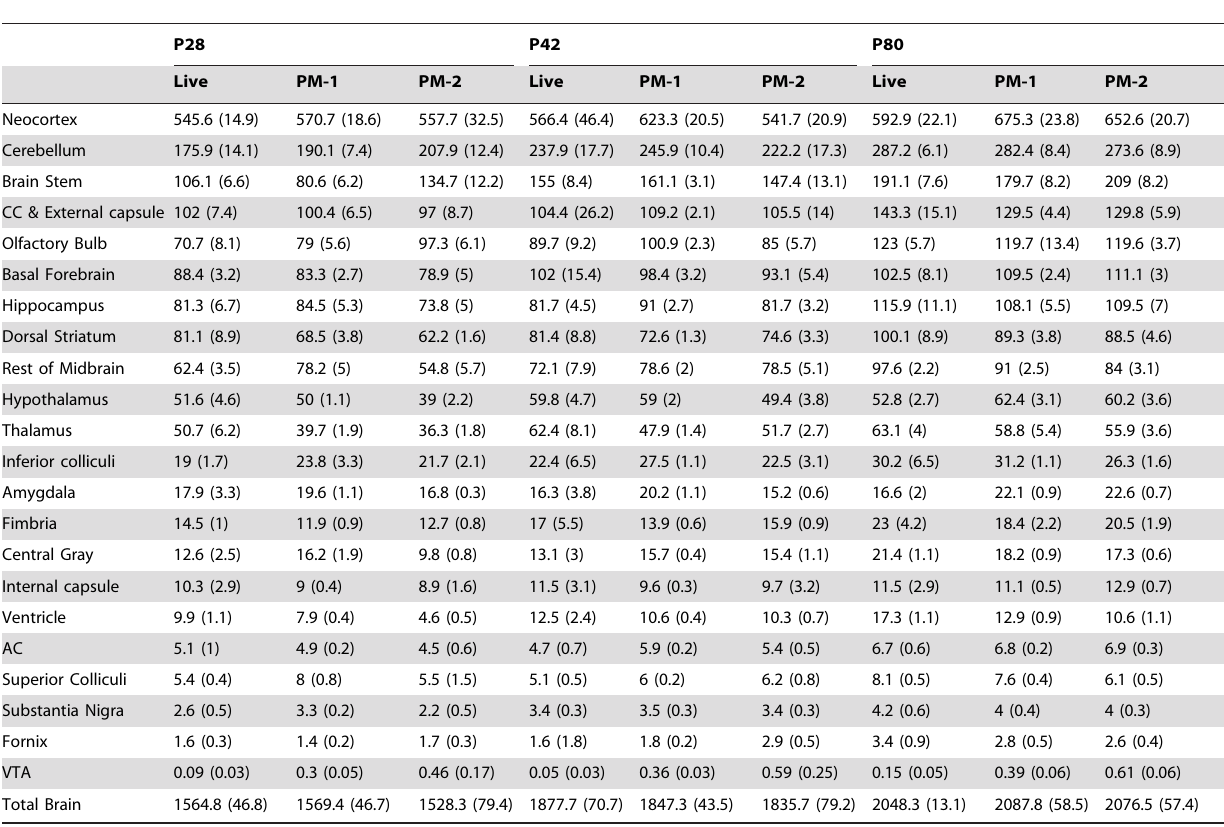
Table 1. Descriptive statistics for volumetric measurements for each age group and scan